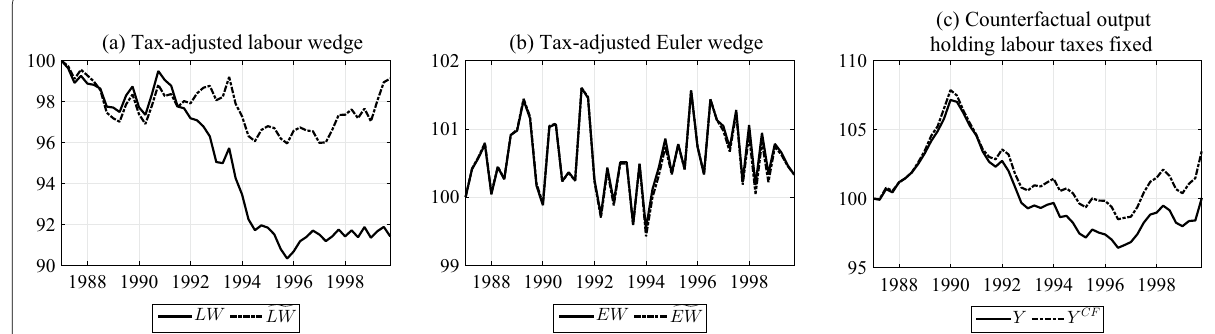
Fig. 16 Robustness: The role of taxes for ν = 0.5 (1987Q1–1999Q4). LW and